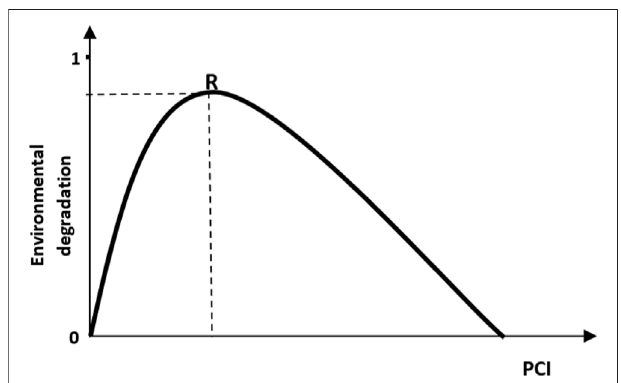
FIGURE 1 | Environmental Kuznets ’